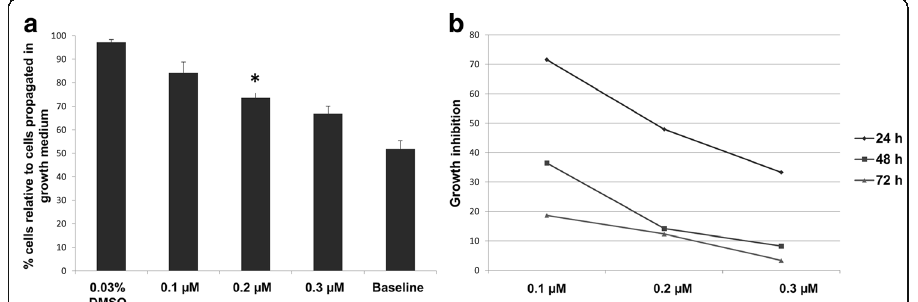
Fig. 1 The effects of ESE-16 on HeLa cell proliferation. a The HeLa cell numbers are expressed as a % of cells relative to cells in growth medium only after 24 h of exposure to ESE-16 (0.1, 0.2 and 0.3 μ M). Vehicle-treated control cells (0.03% DMSO) are also shown. A significant antiproliferative effect was observed after exposure to 0.2 μ M ESE-16. b The growth inhibitory effect of ESE-16 after 24, 48 and 72 h. A growth inhibition of 48% was observed after 24 h exposure to 0.2 μ M ESE-16. * p